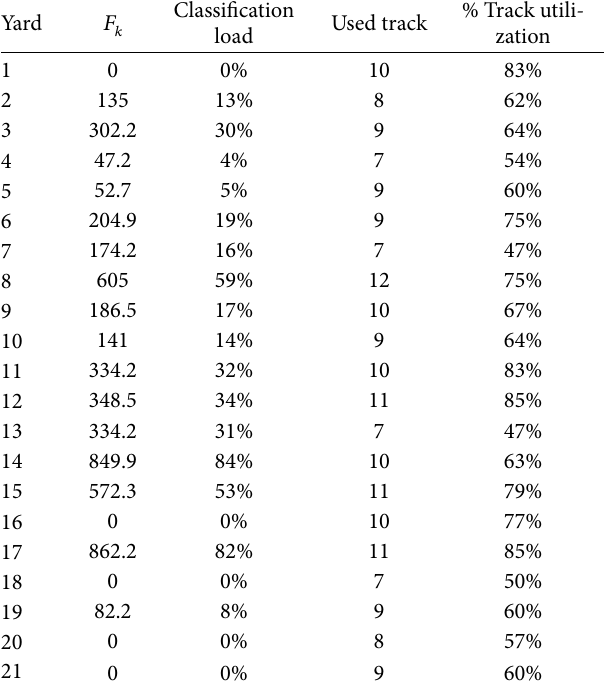
Table 8: Computational results of IGA, SA, and